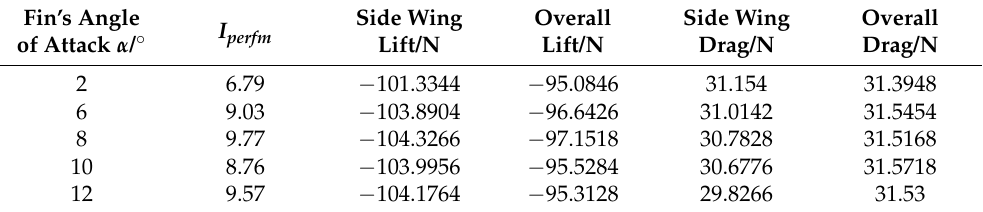
Table 5. Simulation results of the fin’s angle of attack optimization (15 m/s).